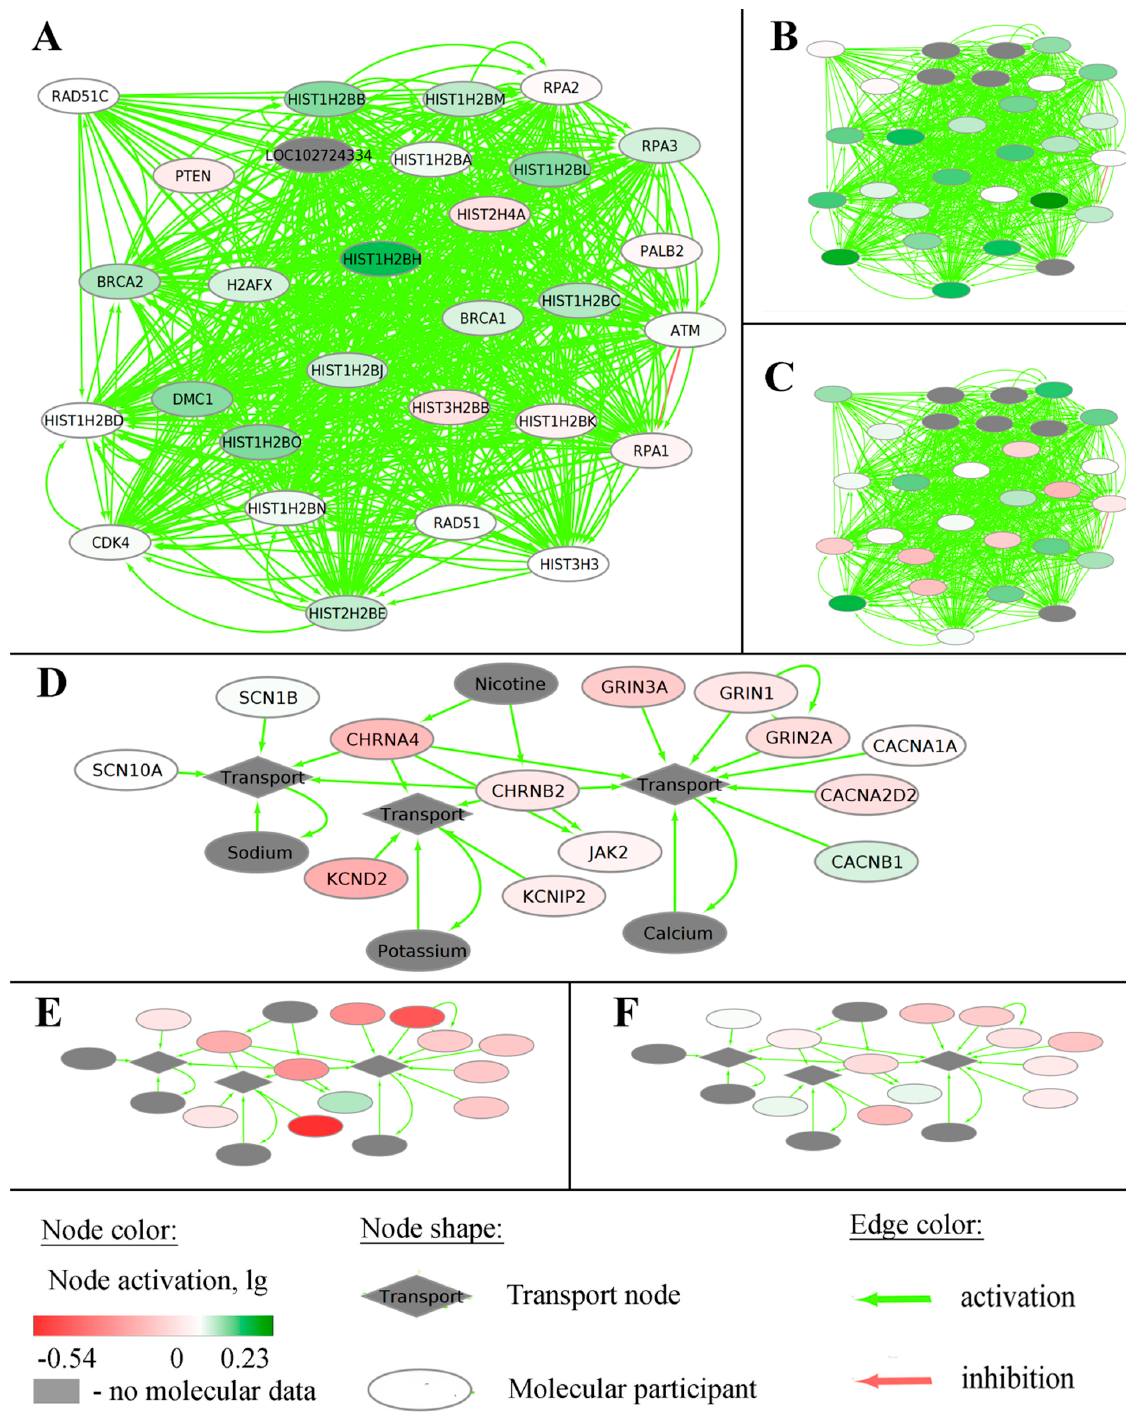
Figure 8. Pathway activation charts of the gene-centric molecular pathways taken as examples. of negative and positive OS biomarkers in LGG. The RAD51C -centric pathway that is linked with negative prognosis shown for averaged ( A ) TCGA, ( B ) CGGA_325, and ( C ) CGGA_693 LGG expression datasets. Nodes on panel A correspond to nodes on panels B and C. The CHRNA4 -centric pathway that is linked with positive prognosis is shown for averaged ( D ) TCGA, € CGGA_325, and ( F ) CGGA_693 LGG expression datasets. Nodes on panel ( D ) correspond to nodes on panels ( E ) and ( F ). Node activation is a logarithmic ratio of the geometric mean of expression in patients with negative prognoses to the geometric mean of expression in patients with positive prognoses.